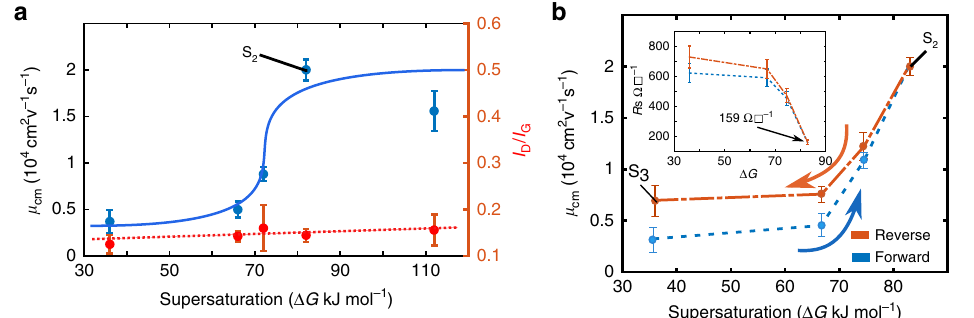
Fig. 2 Reversibility in mobility with reversal in thermodynamic conditions. a Effect of annealing sample S 1 under increasing supersaturations ( Δ G ) on mobility ( µ cm ) and Raman I D /I G ratio. µ cm is seen to increase signi fi cantly with Δ G and then saturate. The averaged defect density as measured by Raman is insensitive to this change. The sample S 2 ( Δ G = 82 kJ mol − 1 ) is indicated. b Reversal of µ cm on reversal of supersaturation, indicating that the phenomenon is thermodynamic in origin and not kinetic. The small hysteresis can be attributed to kinetics. The sheet resistance vs supersaturation and resistance vs gate bias plots are included in the Supplementary Note 6. Samples S 2 and S 3 are